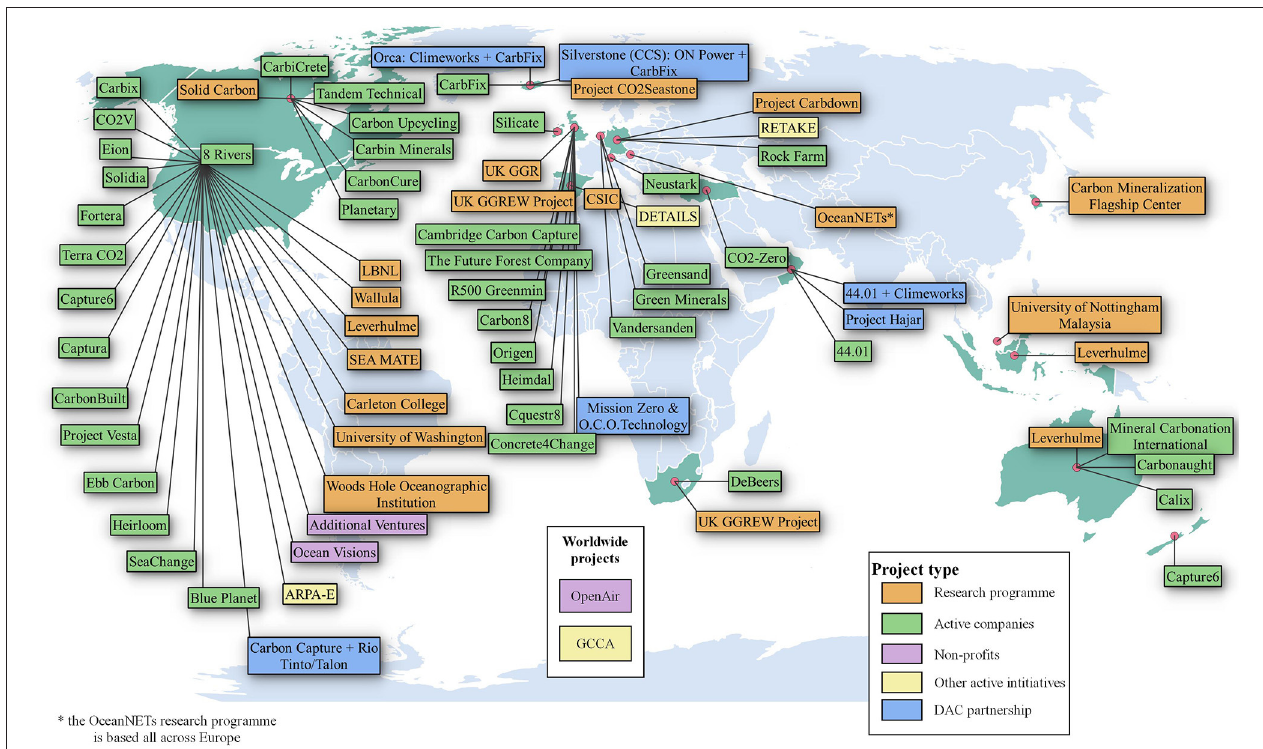
FIGURE 5 | Global map of geochemical NET companies, projects, initiatives and non-profits. The figure includes projects found via basic online searches and may be incomplete. See Supplementary Information for more details and links to the